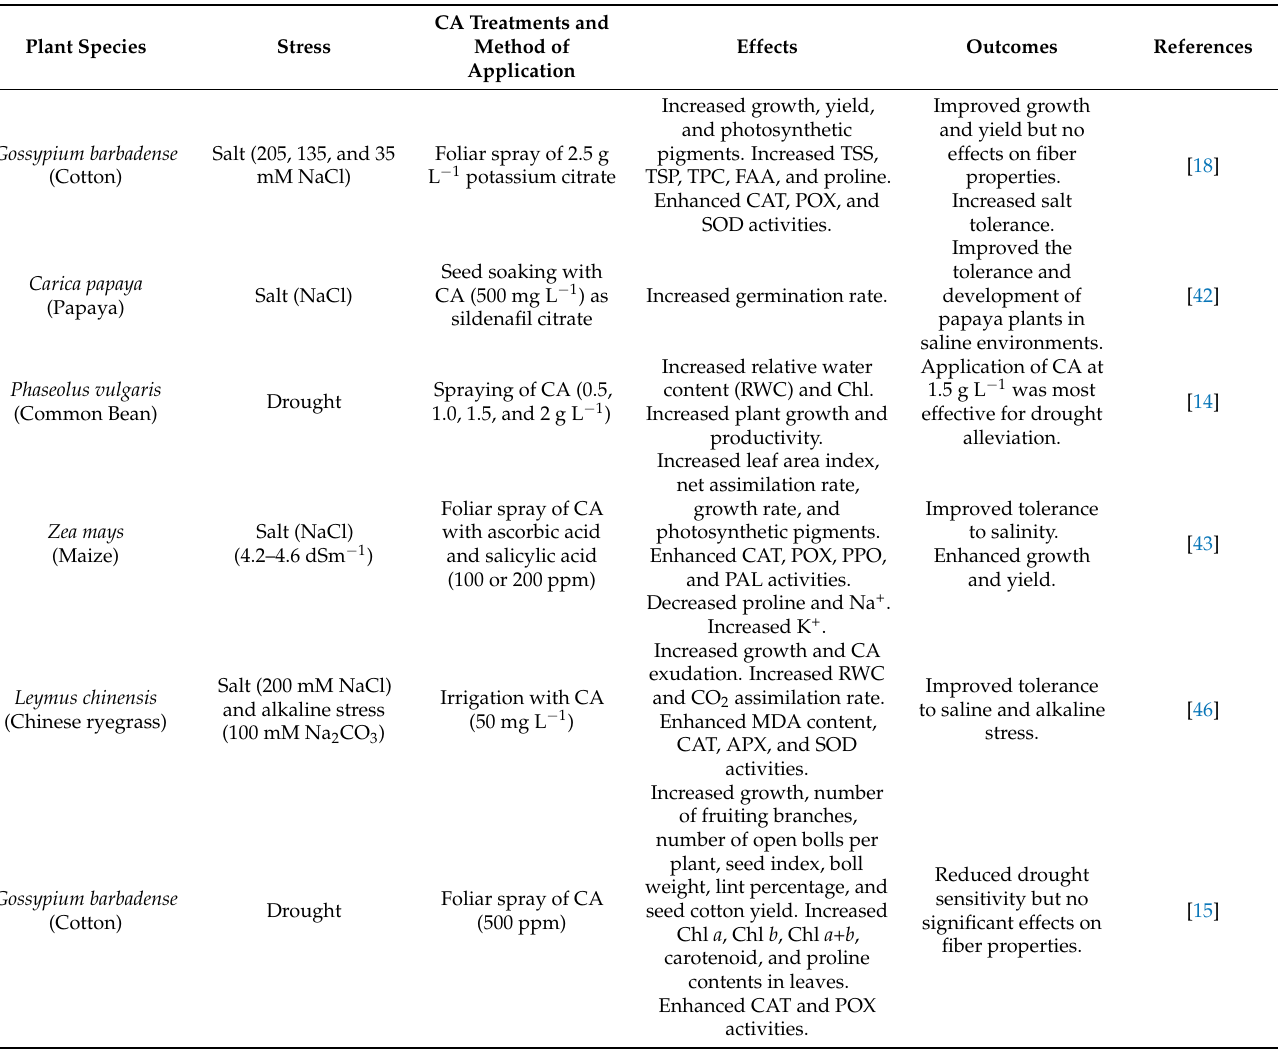
Table 2. Effectiveness of exogenous CA on mediating salinity and drought stress